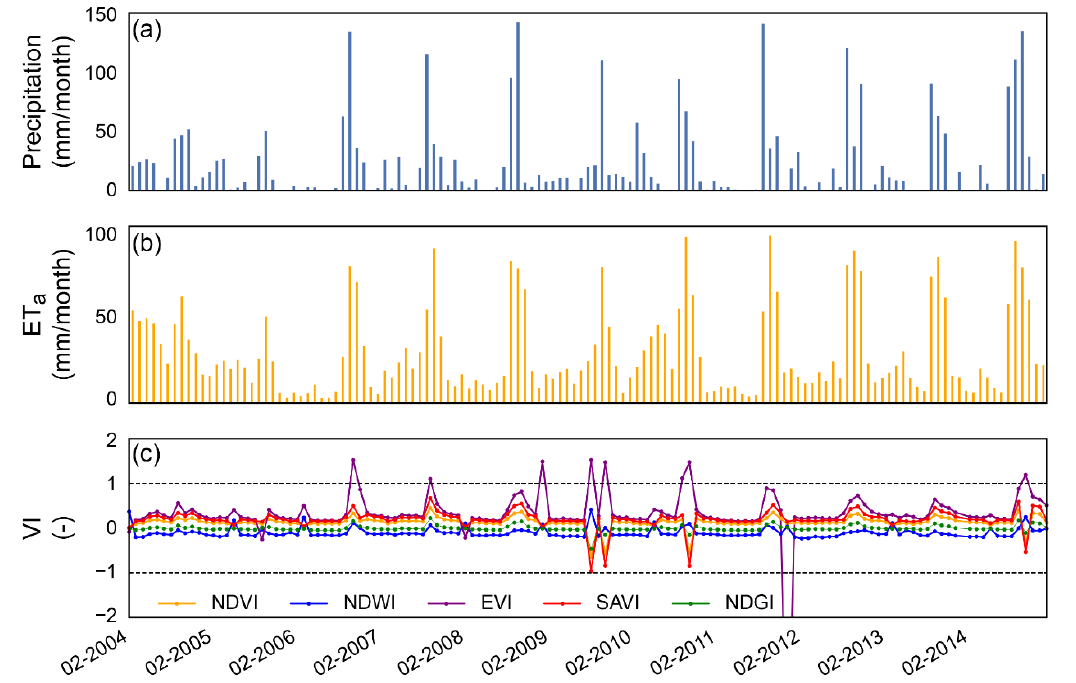
Figure 5. Temporal evolution of monthly precipitation ( a ), monthly ET a ( b ), and monthly VIs ( c ) in US-Wkg.